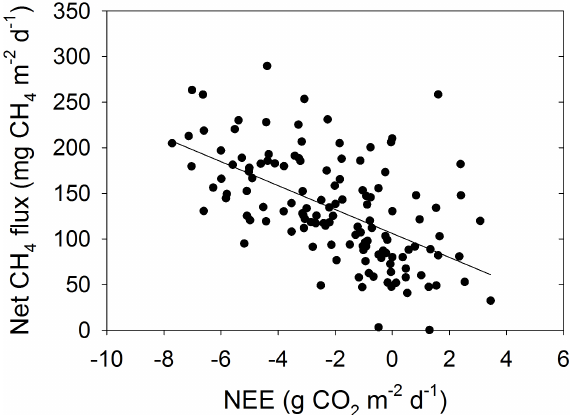
Fig. 6. Relationship between daily net ecosystem CO 2 exchange (NEE) and net daily CH 4 fluxes measured on the same day. Fluxes were measured from 19 May to 27 September 2012. The linear re- lationship has an R 2 of 0.28 and a p value < 0.0001. Positive val- ues represent fluxes to the atmosphere and negative values represent losses from the